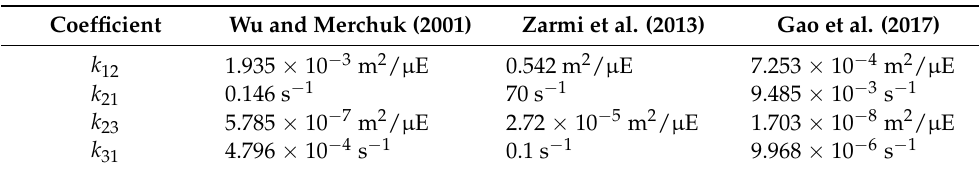
Table 1. Coefficients for the three-state growth model estimated by Wu and Merchuk (2001) [40], Zarmi et al. (2013) [41], and Gao et al. (2017) [31].